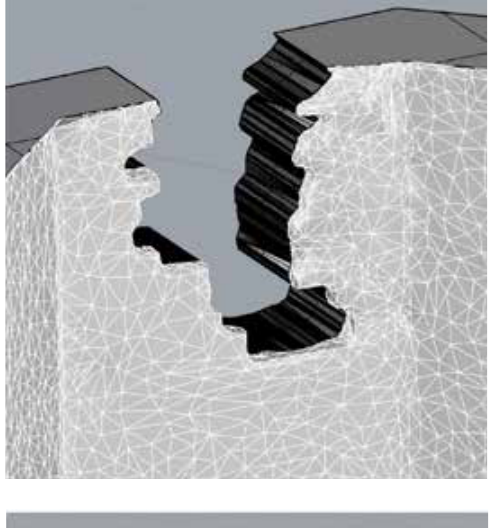
Figure 5 (opposite page; top to bottom, this page): Elaboration of the test bed. 3D modelling of the building’s wall crack and overlapping of the geometry with photogrammetric information. Lidar sensor scans supported the proposed workflow for quick decision-